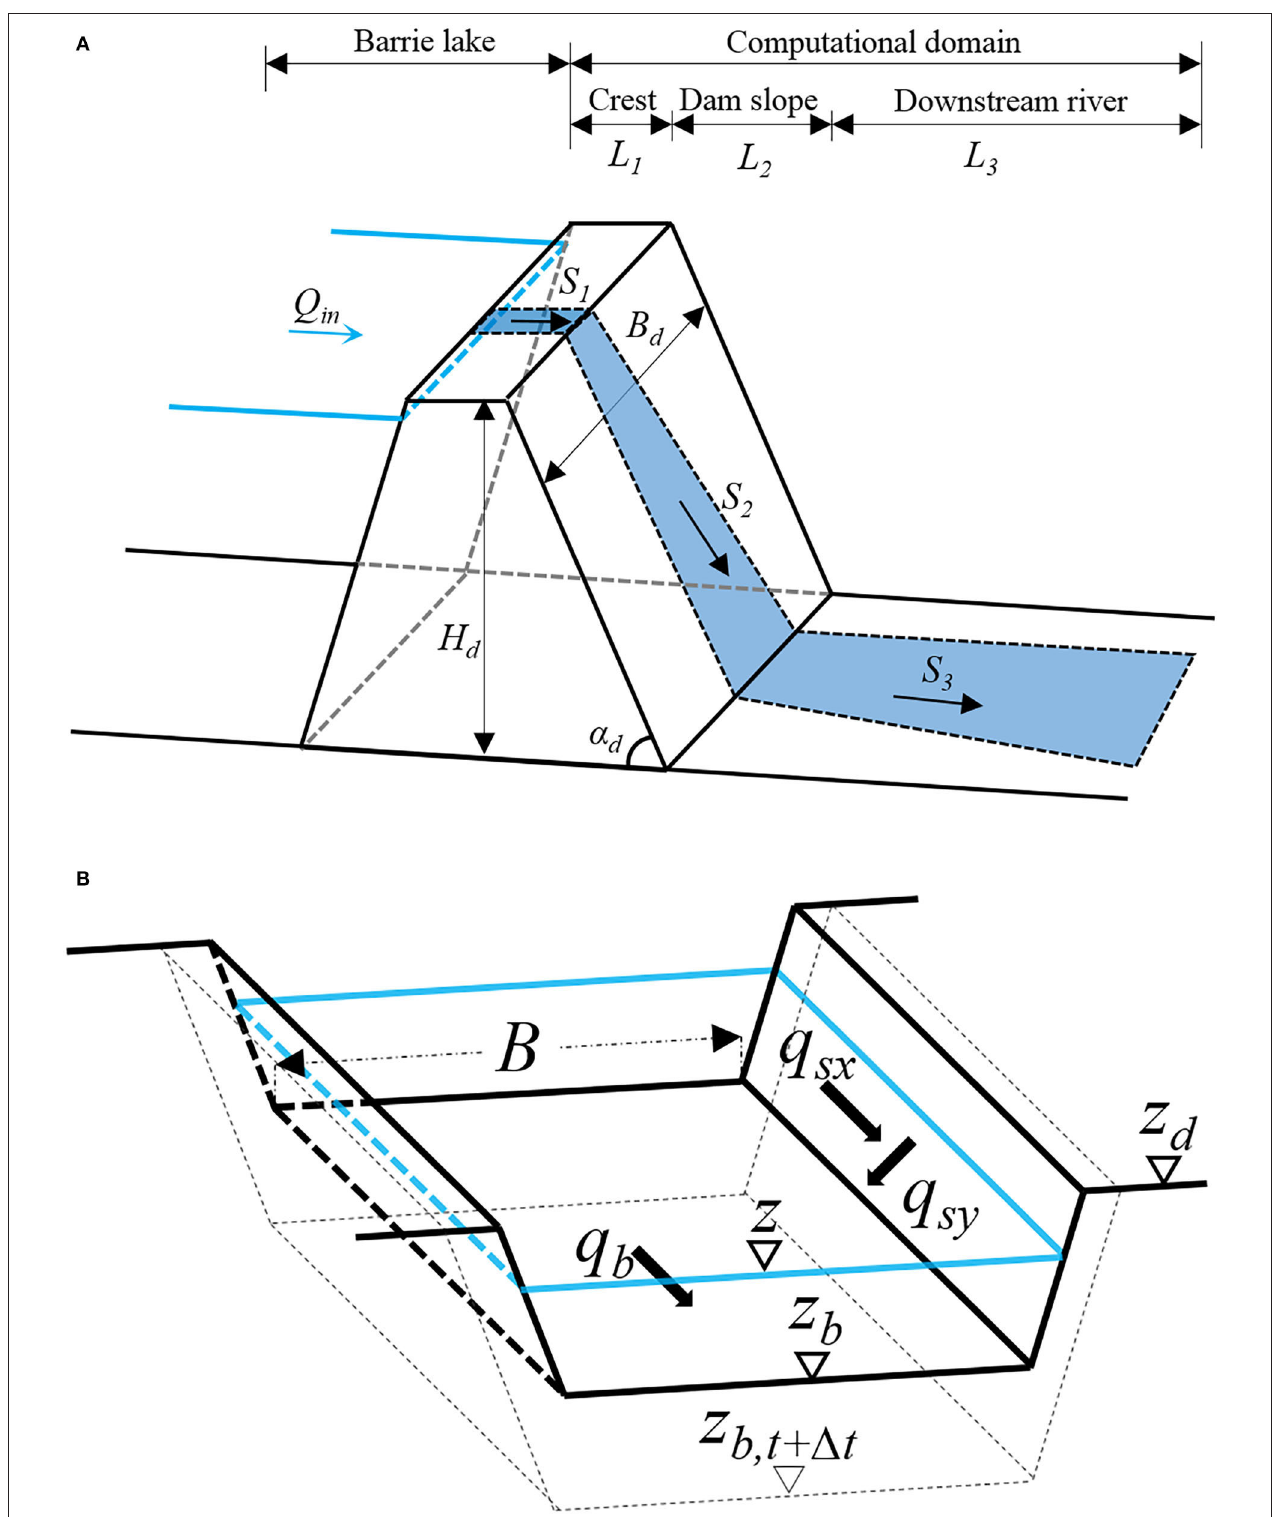
FIGURE 1 | Sketches of a landslide-dam: (A) overview of the computational domain (B) sketch of the cross section and sediment transport rates.